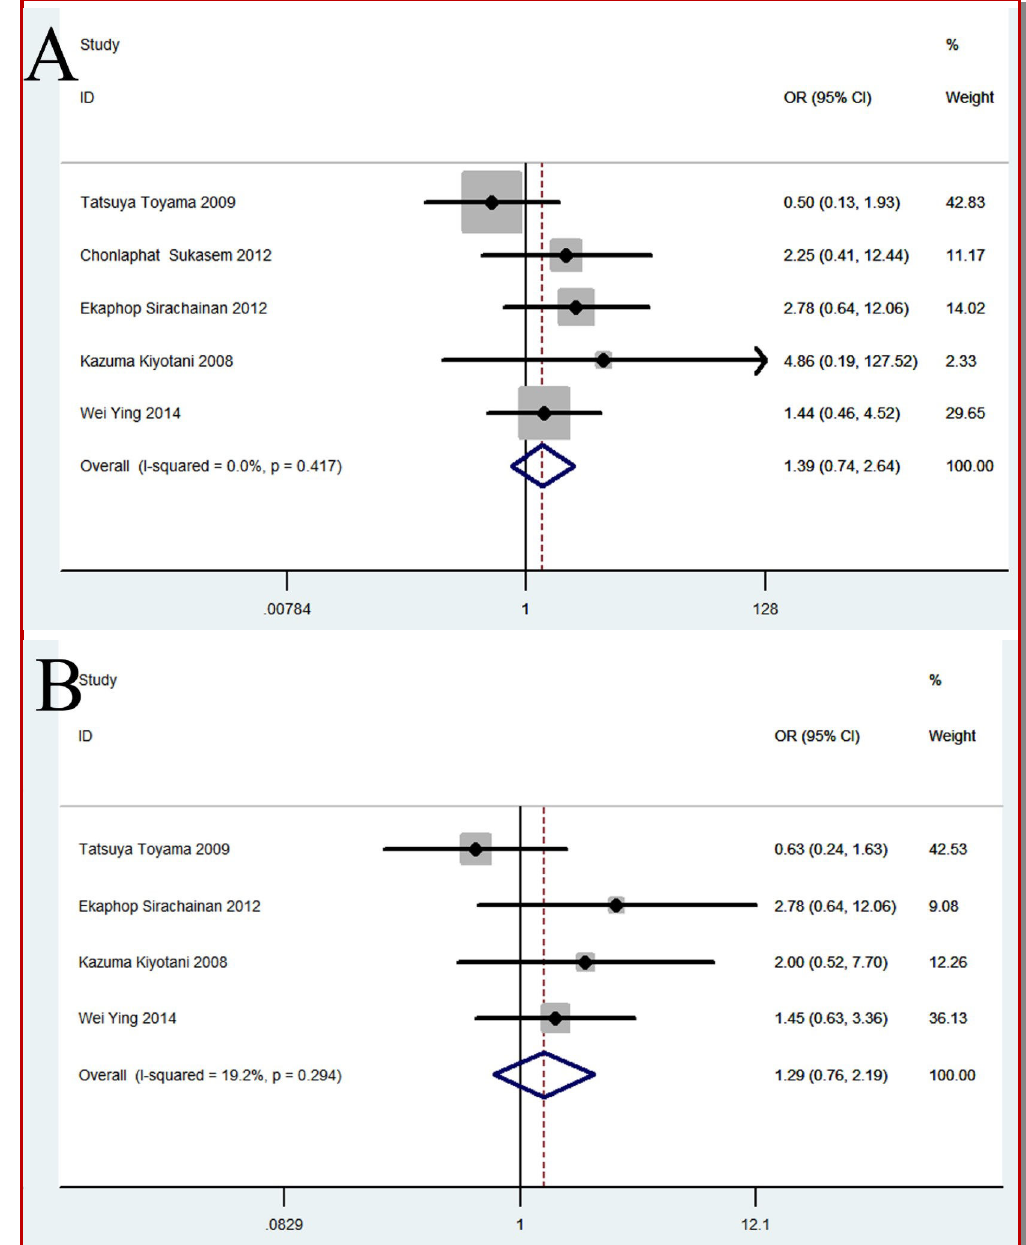
Figure 5: Meta-analysis for DFS of CYP2D6 Wt/*10 vs *10/*10. (A): 5 years-DFS; (B): 10